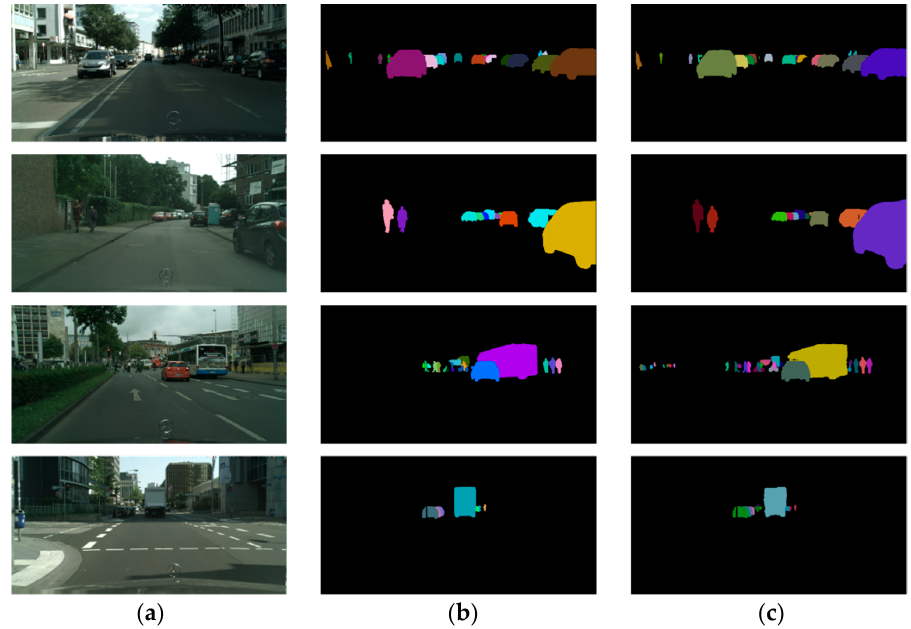
Figure 7. Comparison of instance segmentation results between ground-truth and the proposed method. ( a ) Original images; ( b ) the instance segmentation results of ground-truth; ( c ) the instance segmentation results of baseline with AFPM.